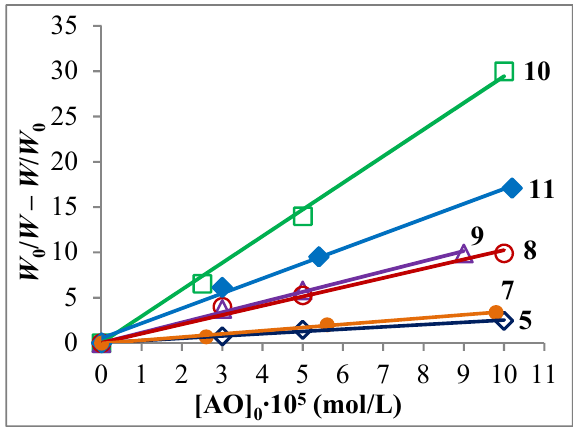
Figure 3. Dependence of induction period of inhibited ethylbenzene oxidation on the initial concentration of compounds 5 , 8 – 10 ( a ) and 7 , 11 ( b ). Temperature 333 K, W i = 5 × 10 –8 mol/L · s.